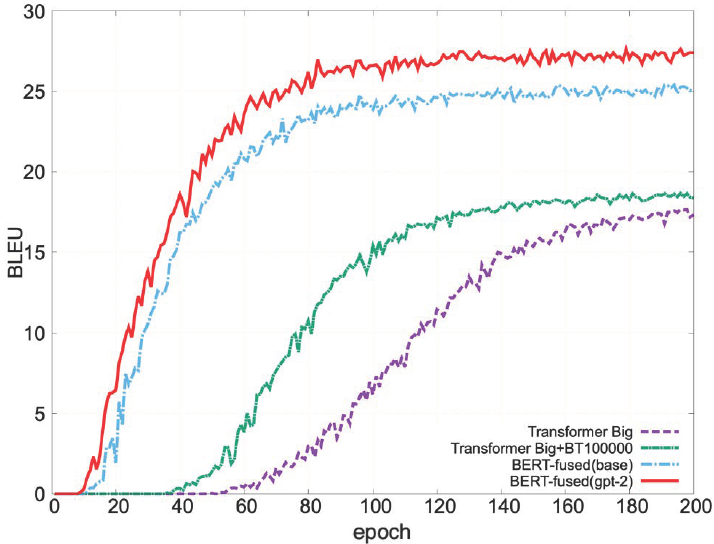
Figure 7. Results of the tatoebaEn-Ja experiment. tatoebaEn-Ja requires a larger number of epochs than the other experiments due to the small amount of data. Therefore, Figure 7 shows up to epoch 200.